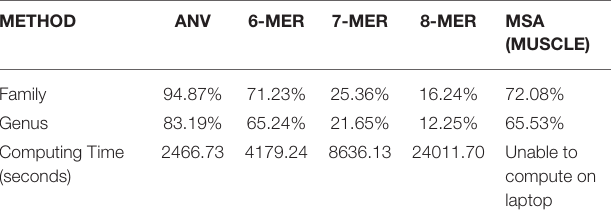
TABLE 3 | Comparison of ANV and k-mer methods on 351 viruses